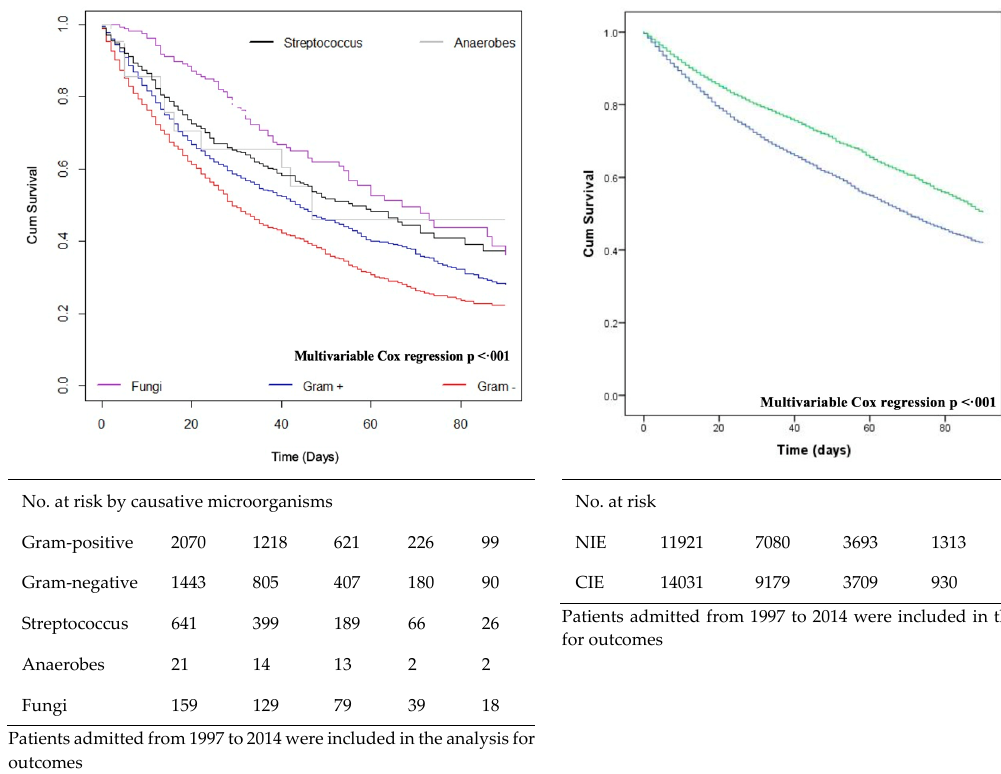
Figure 5. Survival of patients with infective endocarditis stratified by gender ( a ), age groups ( b ), causative microorganisms ( c ), and mode of acquisition ( d ) in Spain.